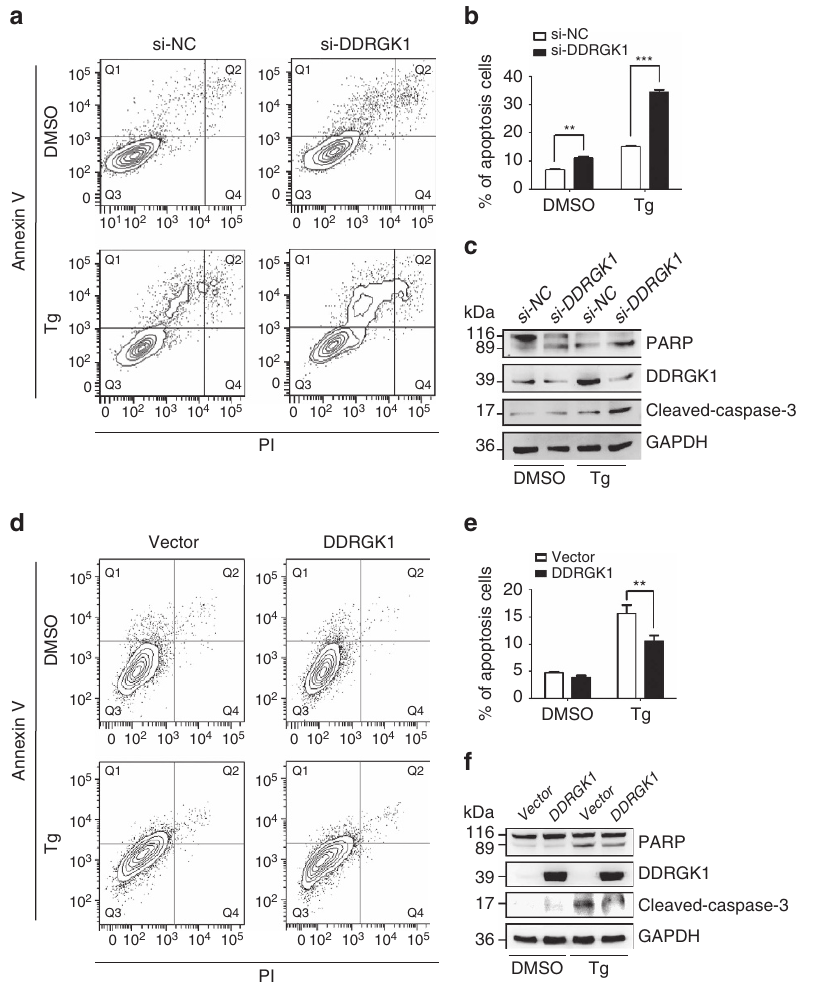
Figure 2 | DDRGK1 plays a protective role in ER stress-induced apoptosis. ( a ). HepG2 cells were transfected with control siRNA or with siRNA against DDRGK1 for 72h, and then the cells were treated with DMSO (vehicle control) or Tg (2.5 m M) for 24h before harvesting. The cells were stained with Annexin Vand PI, followed by flow cytometric analysis. ( b ). Quantification of the apoptotic cells (Annexin V þ ) in a . ( c ) Western blot analysis of PARP and cleaved caspase-3 in the HepG2 cells described in a . ( d ) HepG2 cells were transfected with control vector or DDRGK1 for 36h, and the cells were treated with DMSO or Tg (2.5 m M) for 24h before harvesting. The cells were stained with Annexin V and PI, followed by flow cytometric analysis. ( e ) Quantification of the apoptotic cells (Annexin V þ ) in d . ( f ) Western blot analysis of PARP and cleaved caspase-3 in the HepG2 cells described in d . All data are presented as mean ± s.d. from three experiments. ** P o 0.01 and *** P o 0.001 by Student’s t